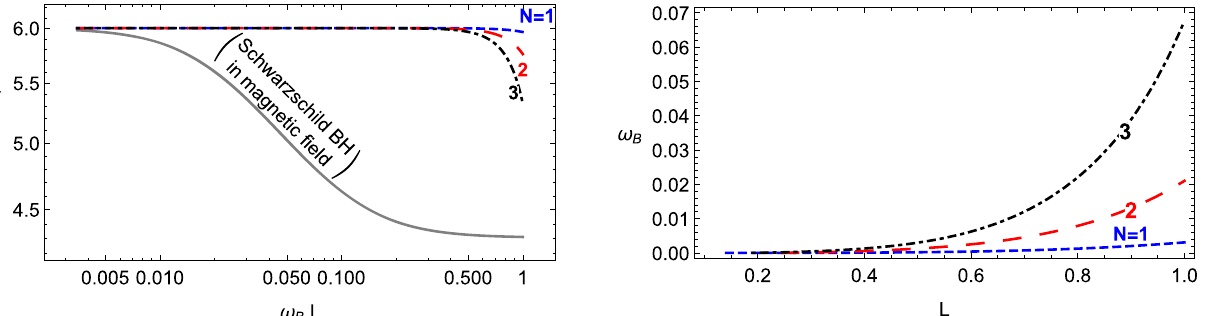
moving around the innermost circular orbit so, turning points of the lines on the graphs represent the ISCO radius; while in c. the lines correspond to the case when energy and angular momentum of the test particle are fixed for the various values of rotation parameter of a black hole.